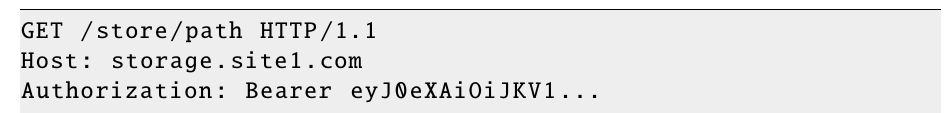
Figure 3. Example HTTP Request with